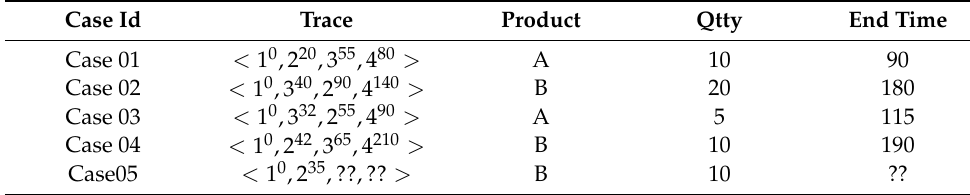
Table 2. Normalization of the event